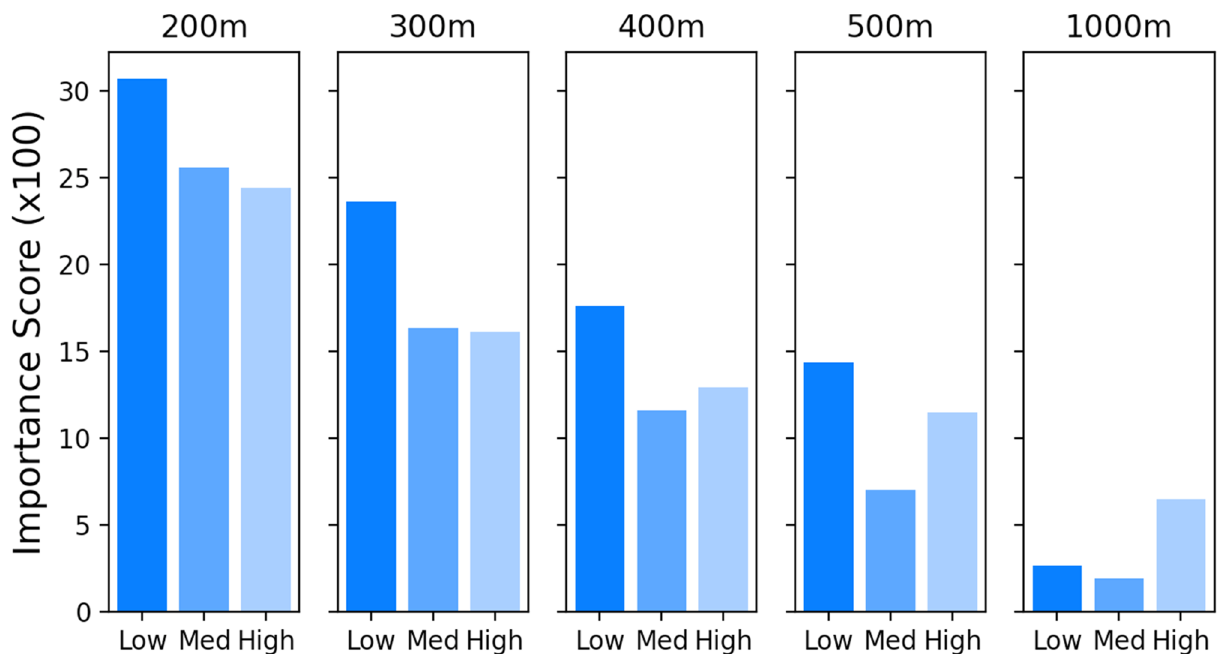
Figure 4. Importance of panel density moderated by income .The importance of solar panel density around an address is computed across different income groups, with density calculated at radii of 200 m, 300 m, 400 m, 500 m, and 1 km. The point value contribution to model performance of the density variable multiplied by 100 is shown on the y-axis, and is compared across income subgroups and five density calculation radii. The importance of panel density within small radii is most pronounced in low-income groups. For larger radii, the relevance is reduced and the income relationship reversed (see Supplementary Figure